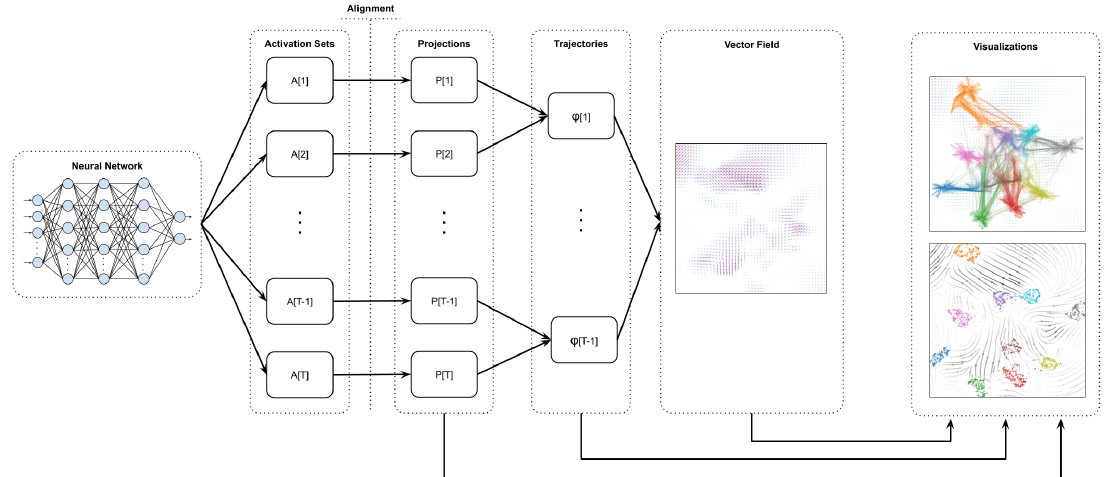
Figure 1. Overview of the learning space vector field generation. From a DNN model, we obtain sequential data in the form of hidden layer activations. We compute projections from this highly multivariate data, aligning them to ensure that obtained projections are synchronized. Differences between each pair of projections in the sequence (transition steps) are turned into trajectories and then processed to obtain vector fields representing changes in data. Finally, everything is combined to compose distinct visual representations of the neural